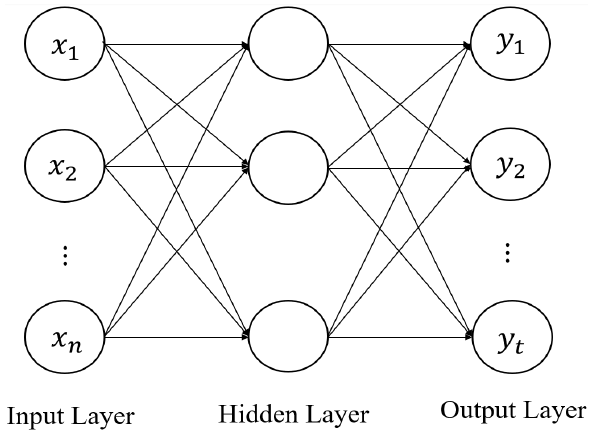
Figure 2. Feed-forward ANNs.